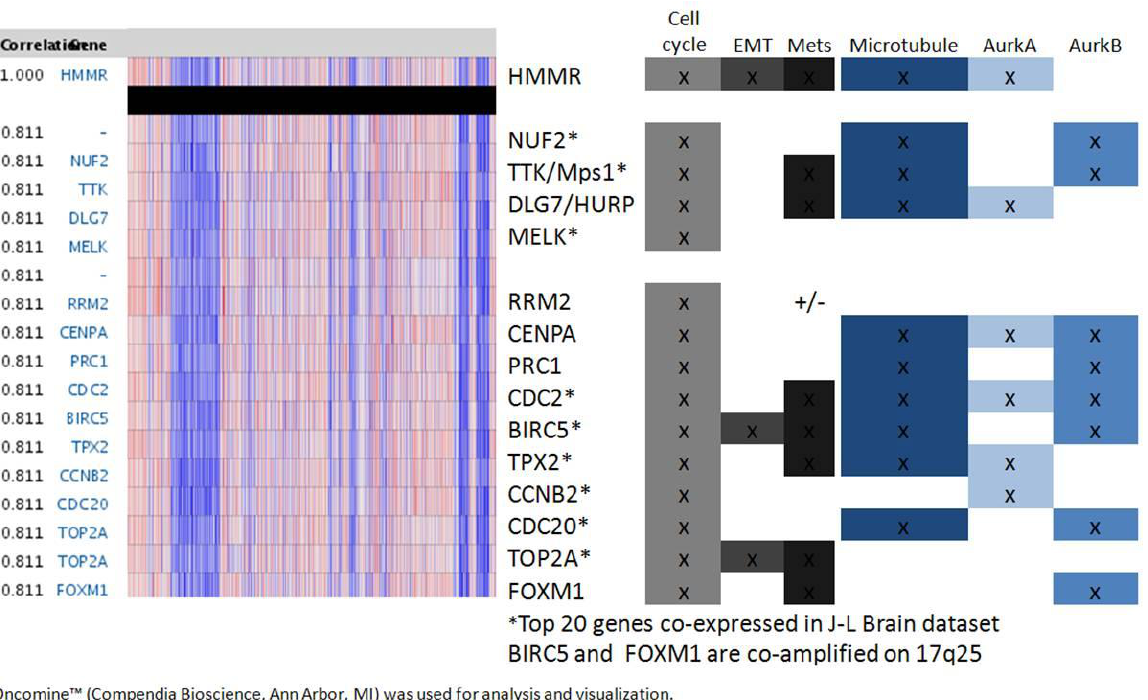
FIGURE 2. Coexpression of mitotic/metastasis genes in cancer. Expression of HMMR /RHAMM correlates to expression of other mitotic genes across multiple tumor sites analyzed in the Bittner[26] and Janoueix-Lerosey Brain[82] datasets. Coexpressed genes/proteins associate with microtubules and interact with aurora kinases. Additionally, expression of these genes/proteins associate with cellular migration, EMT, and adverse tumor outcomes, such as metastasis (Mets). Oncomine™ (Compendia Bioscience, Ann Arbor, MI) was used for analysis and